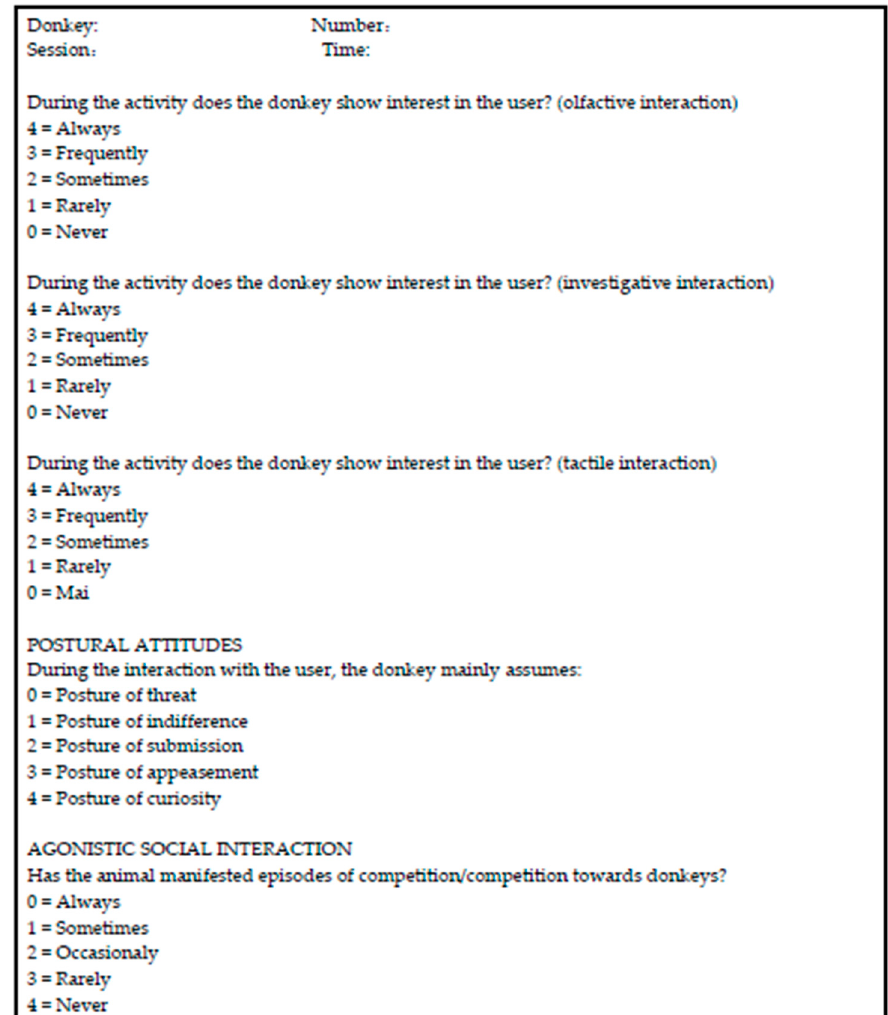
Figure 1. Observation form for the donkey’s behavior in during animal-assisted interventions (AAIs).